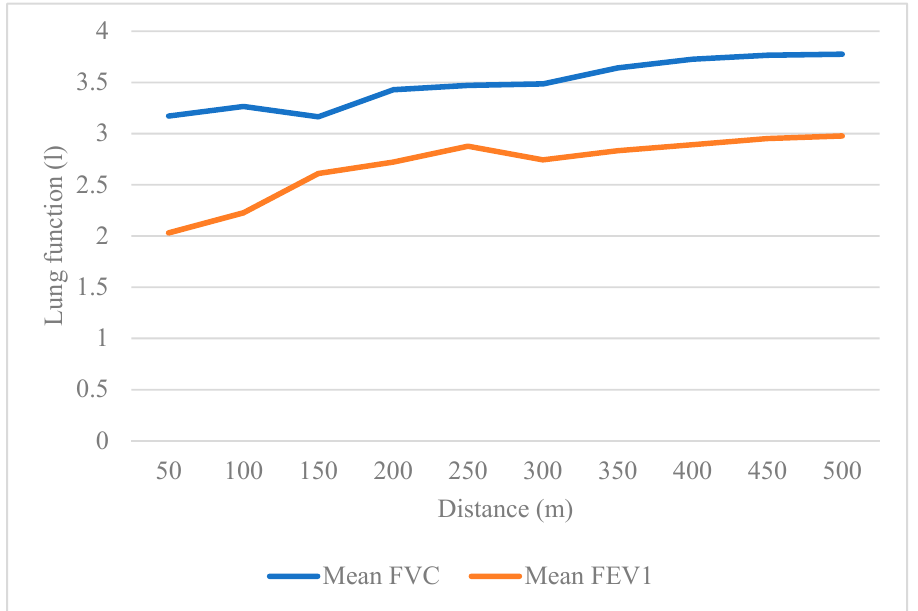
Figure 4. Lung function parameters among the exposed group according to the distance from the quarry site.